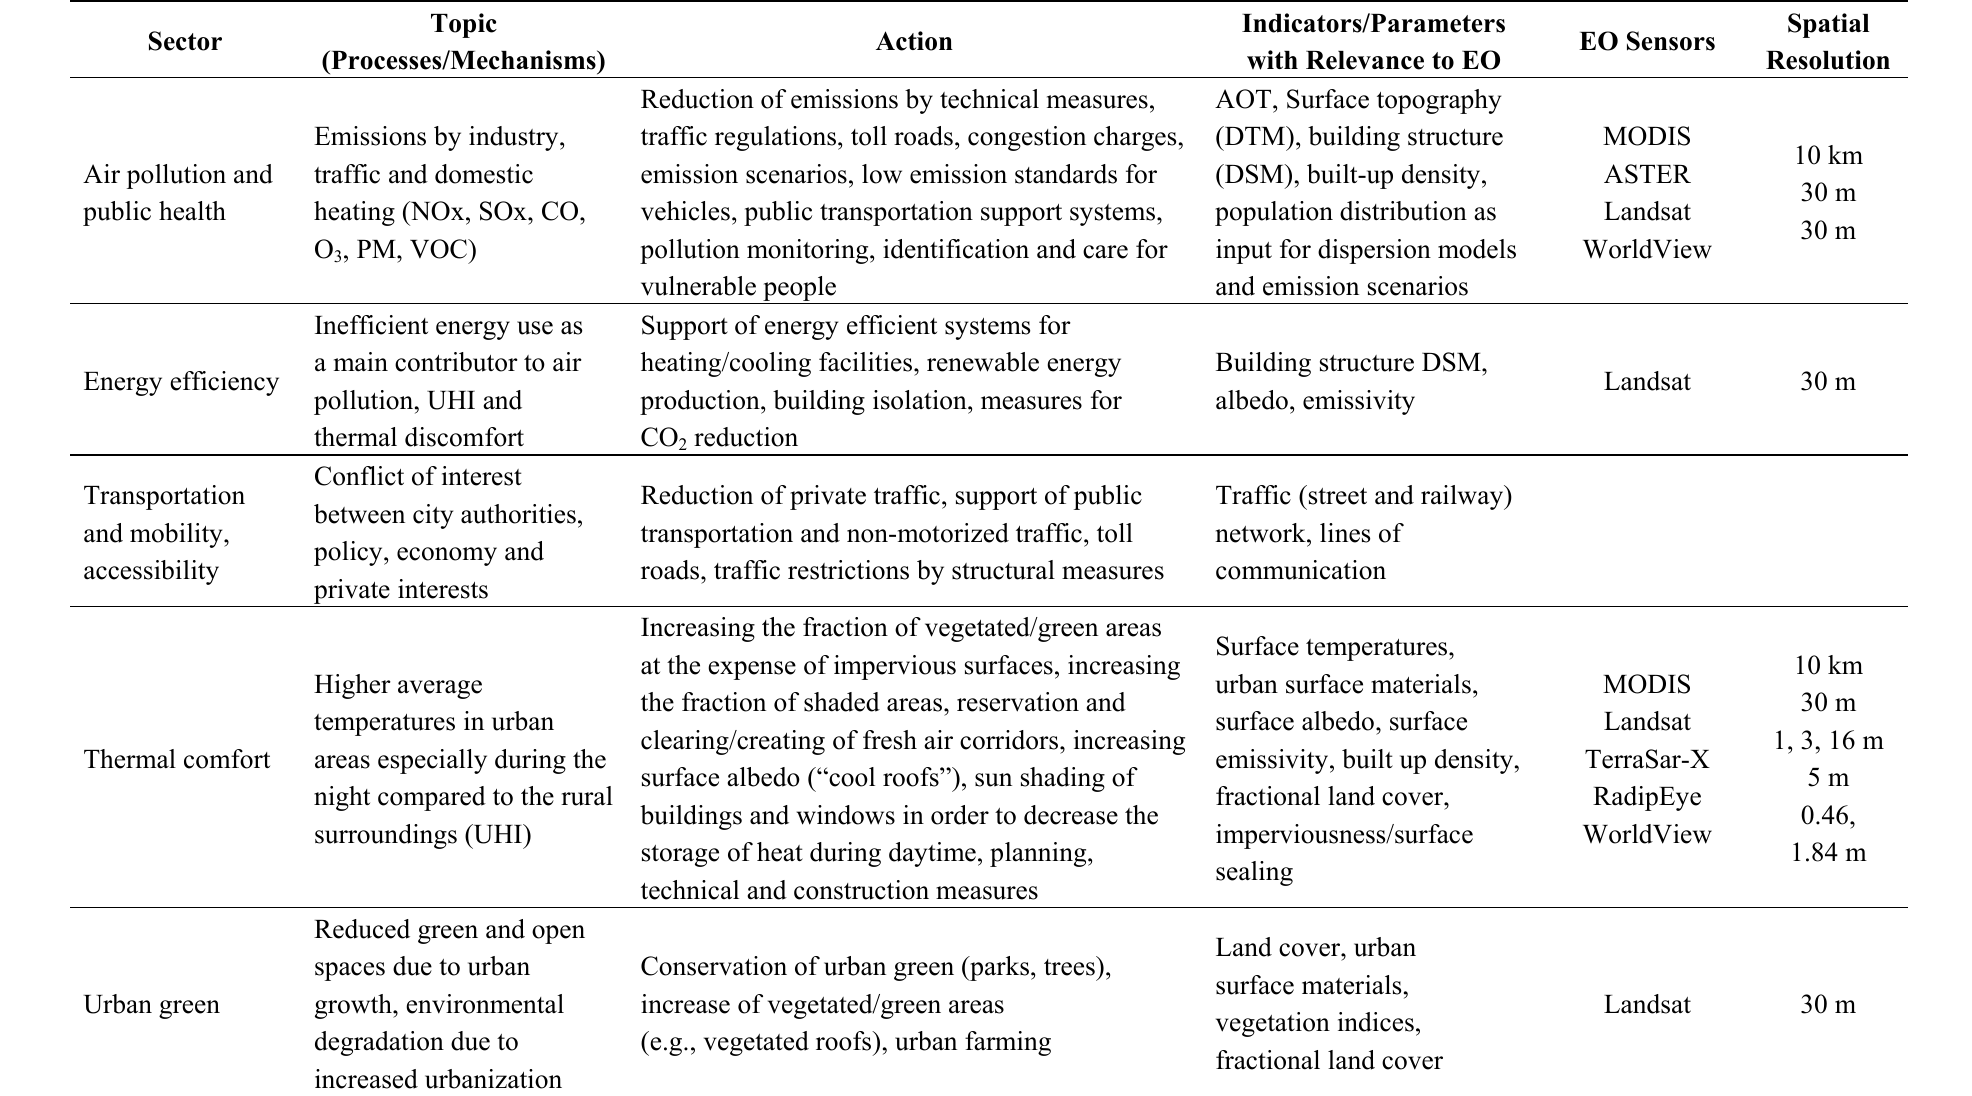
Table 1. Routine requirements and the associated Earth Observation (EO)-based products and